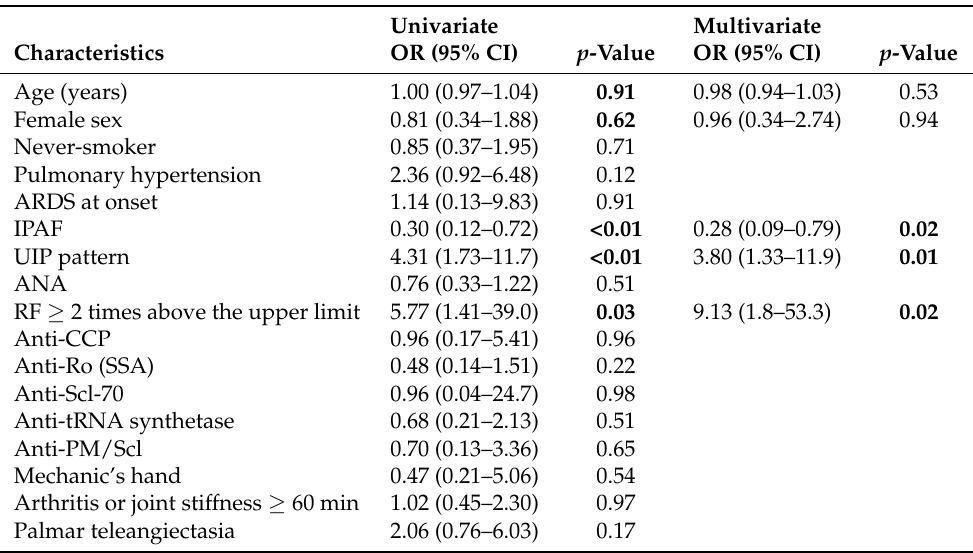
Table 4. Factors predicting the composite endpoint of ILD progression at 12 ± 3 months from the diagnosis (T1) in the total ILD cohort, as determined by logistic regression